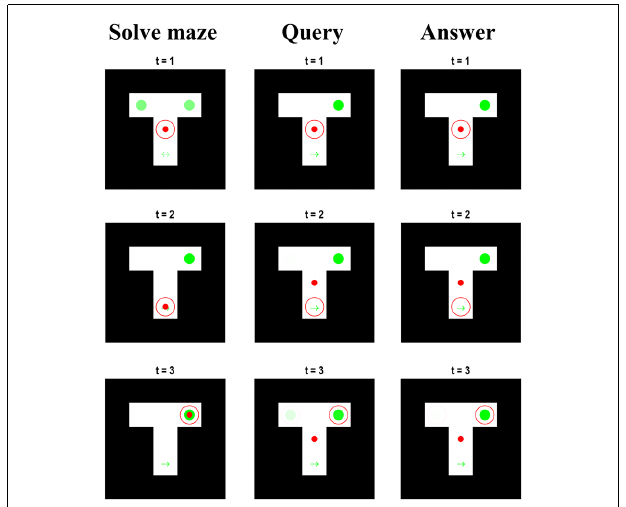
FIGURE 4 | Maze beliefs and replay . This figure reports the beliefs of the agent for the first three time-steps during each of the slower epochs at the narrative level. Each column of images displays a single epoch, with each row displaying the beliefs (and location) at each of the first three steps. The format of each image is the same as in Figure 2 . These can be regarded as visual displays of the belief updates shown in Figure 3 . The important things to note are: (i) that maze-solving epoch is identical to that of Figure 2 , (ii) that the true location (i.e., red dot) is central in the query and answer epochs, (iii) that the context is known from the start in the latter two epochs, and (iv) that the beliefs about the location hidden states are consistent throughout all three